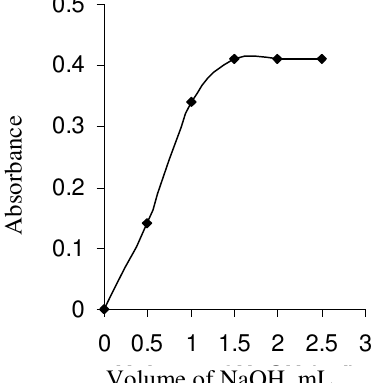
Figure2. Effect of sodium hydroxide concentration (90 µ g mL -1 drug + 1.0 mL of F-C